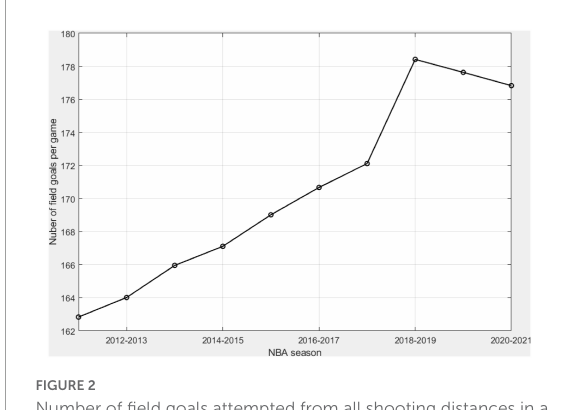
FIGURE2 Number of field goals attempted from all shooting distances in a game for each season between the 2011–2012 regular season and the 2020–2021 regular season.